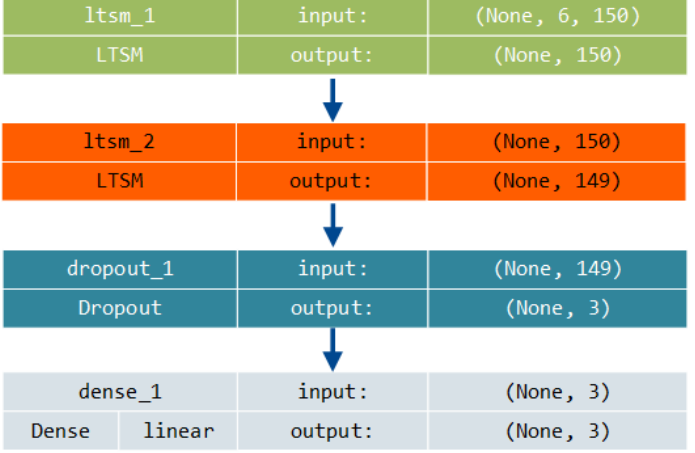
Figure 12. The structure of the best produced model -